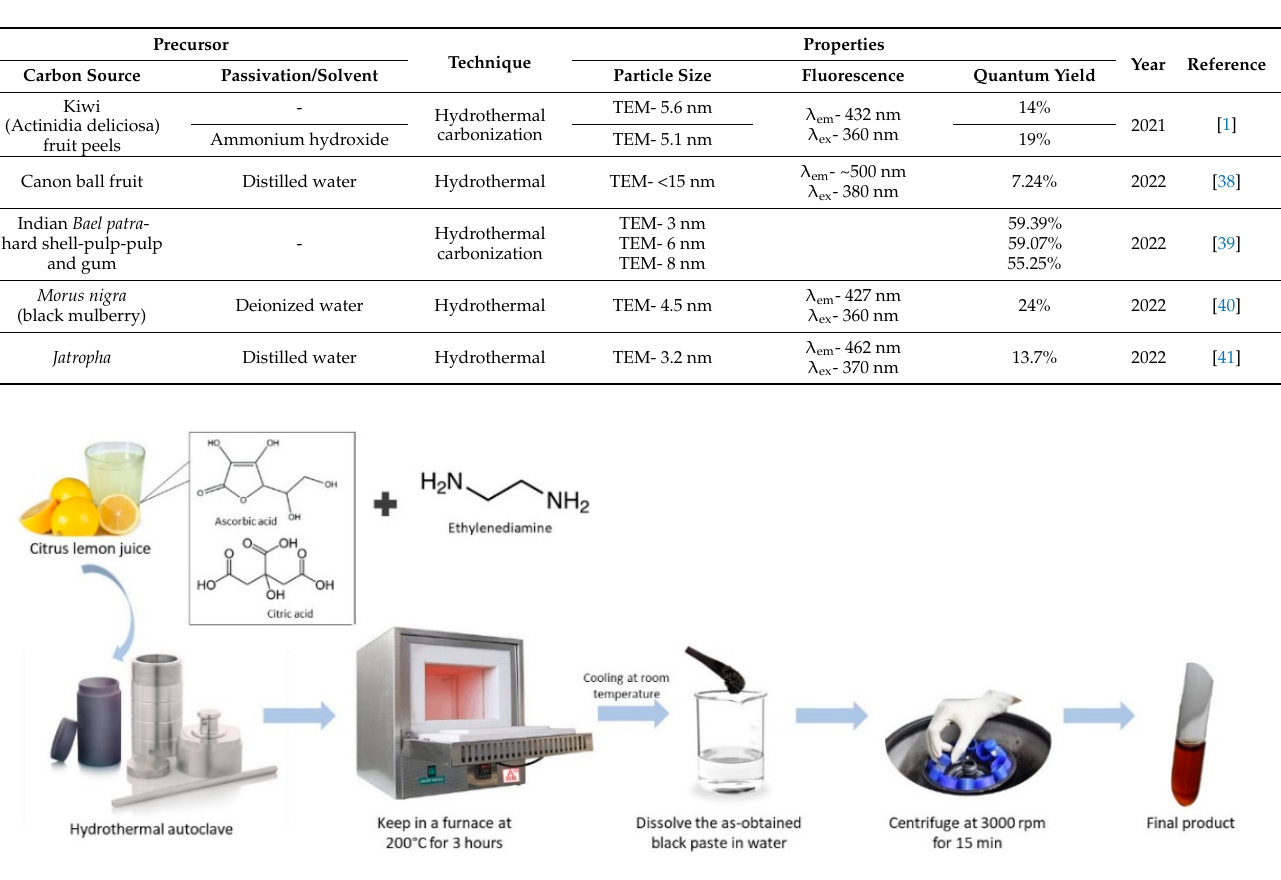
Figure 1. Schematic of hydrothermal reaction of CDs from citrus lemon juice and ethylenediamine. Table 1. Summary of the synthesis CDs from fruits.